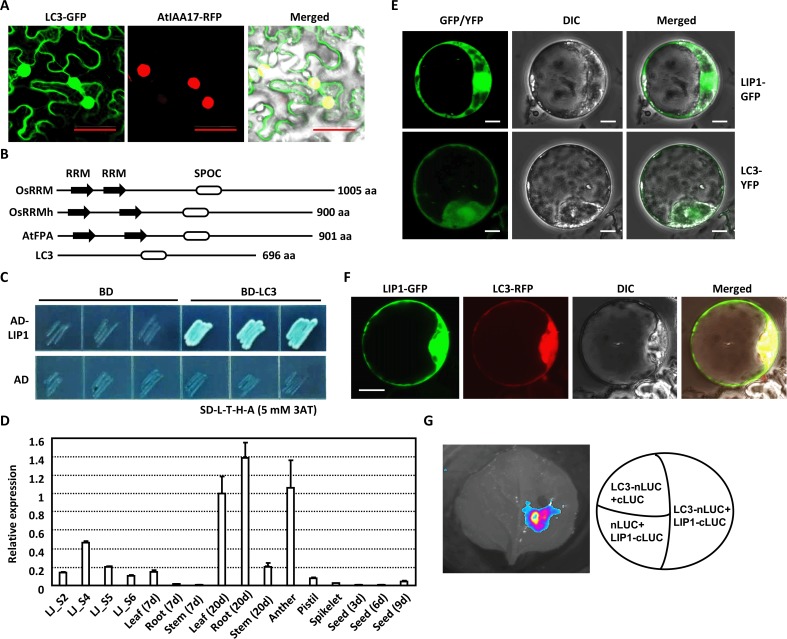
LC3 interacts with LIP1, a HIT zinc finger domain-containing protein.(A) Subcellular localization analysis reveals the ubiquitous LC3 distribution in nucleus, cytoplasm, and plasma membrane. LC3-GFP and nucleus-localized Arabidopsis AtIAA17-RFP fusion proteins were transiently co-expressed in N. benthamiana leaves and observed. Bar = 50 μm. (B) Structural organization of LC3 and comparison with representative proteins containing SPOC and conserved RRM (RNA recognition motif) domains in rice and Arabidopsis.(C) Yeast-based two-hybrid analysis reveals the LC3-LIP1 interaction. Yeast transformants were grown on synthetic dropout (-Leu/-Trp/-His/-Ade) plates plus X-α-Gal and 3-AT (3-amino-1, 2, 4-triazole, 5 mM) for 4 days. (D) qRT-PCR analysis reveals the LIP1 transcript in various tissues. Transcription levels were normalized with that of Actin and LIP1 expression level in leaf at 20 days was set as 1.0. Analyses were repeated three times and data are shown as means ± SE. (E)Subcellular localization analysis shows the localization of LC3 and LIP1. LC3-YFP and LIP1-GFP fusion proteins were transiently expressed in rice protoplasts. Bar = 5 μm. (F) LC3 co-localizes with LIP1 in cell nucleus and cytoplasm. LIP1-GFP and LC3-RFP fusion protein were transiently co-expressed in rice protoplasts, and representative images are shown. Bar = 10 μm. (G) Split-LUC (luciferase) assay shows the LC3-LIP1 interaction in N. benthamiana leaves. Fusion protein LC3-nLUC was co-transformed with LIP1-cLUC into tobacco leaves.